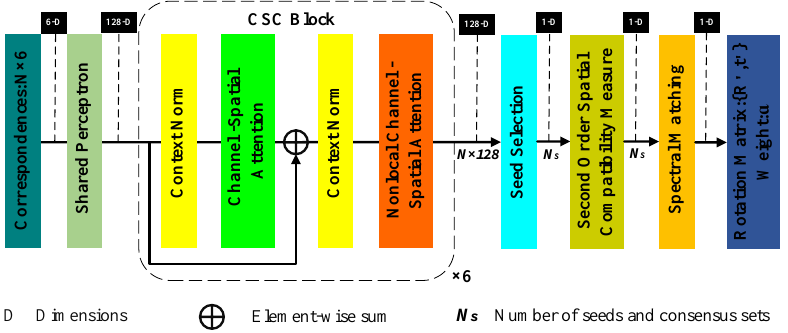
Figure 2. The framework diagram of our CSCE-Net. It contains several CSC block blocks, a Seed Selection mechanism, a Second Order Spatial Compatibility Measure, and Spectral